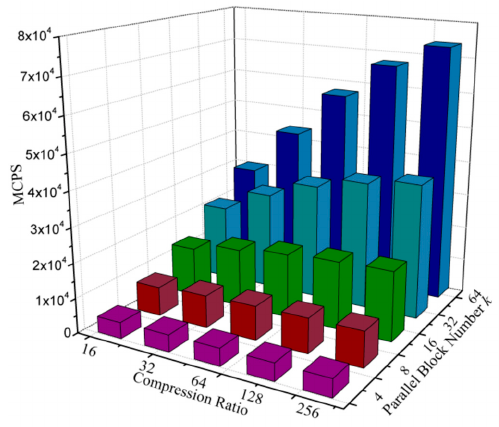
Figure 8. MCPS (million connections per second) of the proposed vector quantizer with different compression ratio and parallel block number.